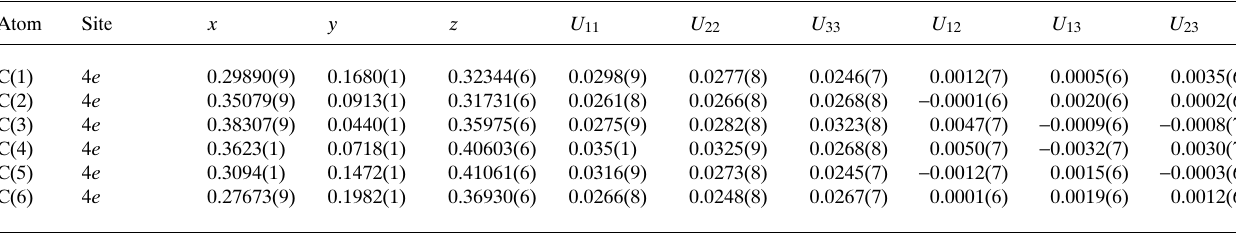
Table 3. Atomic coordinates and displacement parameters (in Å 2 )